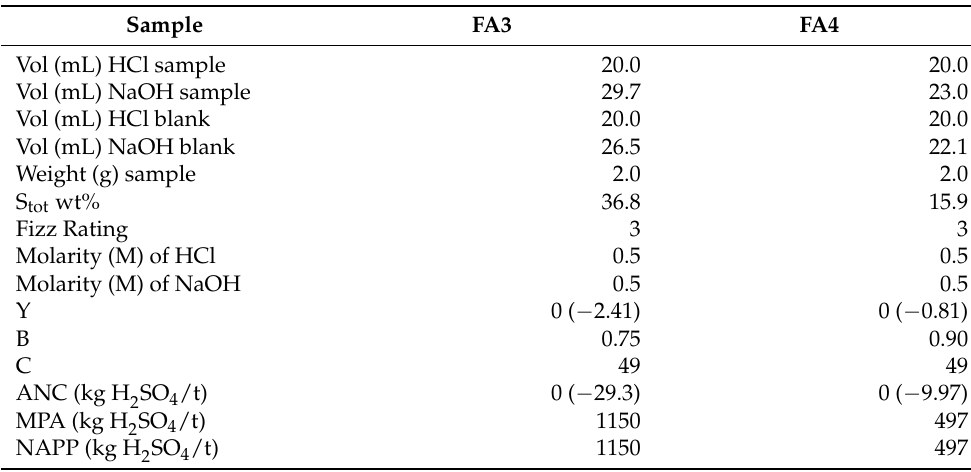
Table 3. Calculation of ANC ANC = [Y × M HCl /wt] × C, where: Y = (Vol. of HCl added) − (Vol. of NaOH titrated × B); B = (Vol. of HCI in blank)/(Vol. of NaOH titrated in blank); C = Conversion factor (to calculate kg H SO 4 2